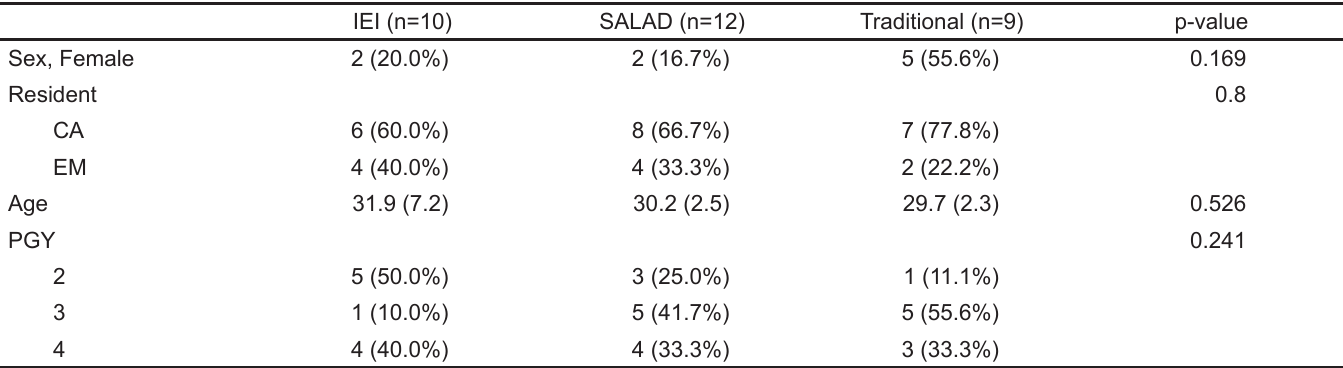
Table 1. Baseline Characteristics.